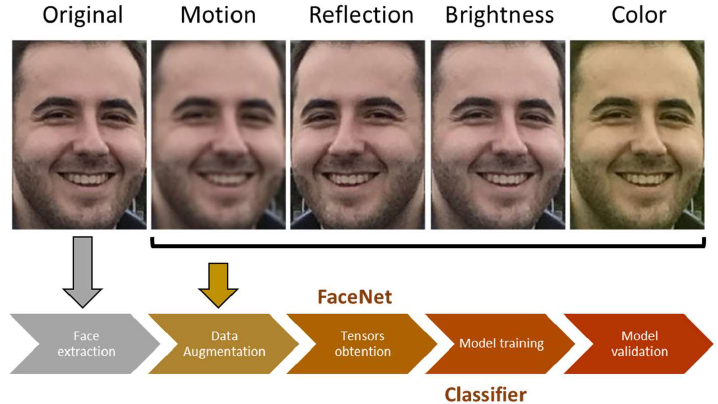
Figure 9. Pipeline for creating each user’s classifier and example of data augmentation.